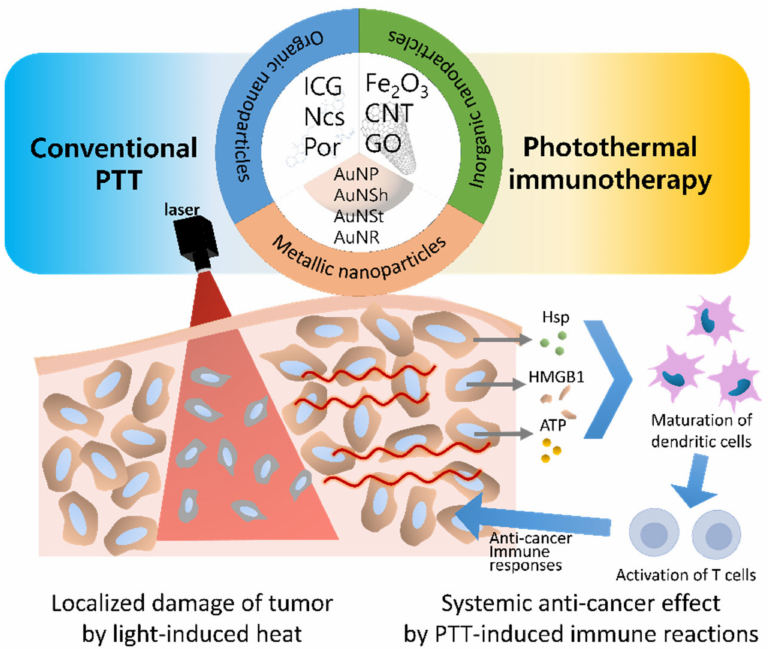
Figure 1. Schematic diagram of nanoparticles for photothermal therapy (PTT) according to the therapeutic mechanisms. Conventional PTT gives priority to the cell death (necrosis or apoptosis) of targeted cancer in the radiated area. In contrast, photothermal immunotherapy focuses on the immune reactions after PTT for systemic anti-cancer effect. (Abbreviations: PTT—photothermal therapy; ICG—indocyanine green; Ncs—naphthalocyanines; Por—porphyrin; CNT—carbon nanotubes; GO— graphene oxide; AuNP—gold nanoparticles; AuNSh—gold nanoshells; AuNSt—gold